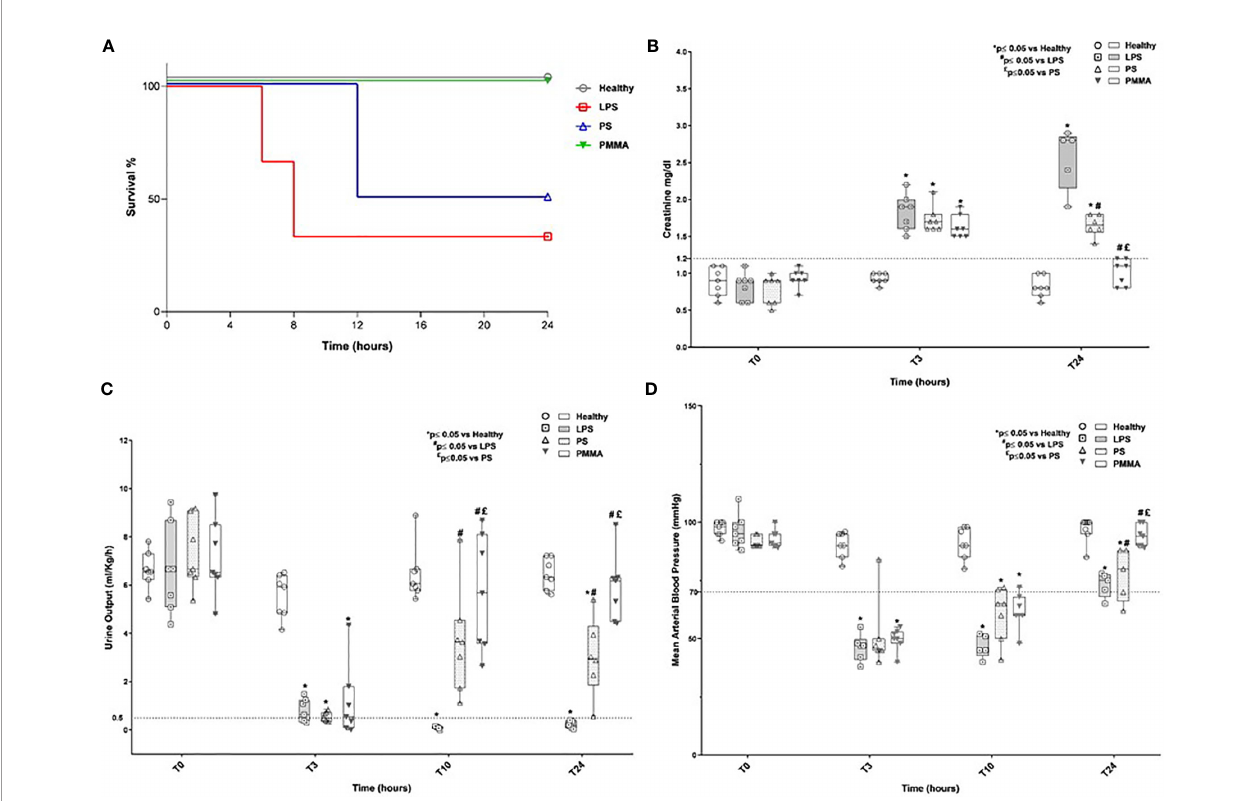
FIGURE 1 | Survival rate, renal function, oligo-anuria, and hypotension in a swine model of LPS-induced AKI. (A) Three animals (two animals of the LPS group and one animal of the PS group) died because of severe low blood pressure before completing the study protocol. (B, C) Endotoxemic pigs developed AKI with time- dependently increased creatinine serum levels and reduced urinary output. PMMA-CVVH treatment signi fi cantly reversed LPS effects ( # p < 0.05 vs LPS, and £ p < 0.05 vs PS). (D) After LPS infusion, animals presented hypotension and PMMA-CVVH treatment recovered MAP levels more than PS-CVVH treatment. (B – D) PS-CVVH treatment was no effective to recover creatine level, urine output, and arterial blood pressure to baseline median of healthy group. Data were obtained as described in the Methods section and expressed as median ± IQR of at least fi ve pigs for each group (Healthy group and PMMA group, n = 7 for all time points; LPS group, T0-T3 n = 7, T10-T24 n = 5; PS group, T0-T3-T10 n = 7 and T24 n = 6). Statistically signi fi cant differences were assessed by the Mann – Whitney test (*p < 0.05 vs Healthy, # p < 0.05 vs LPS, and £ p < 0.05 vs